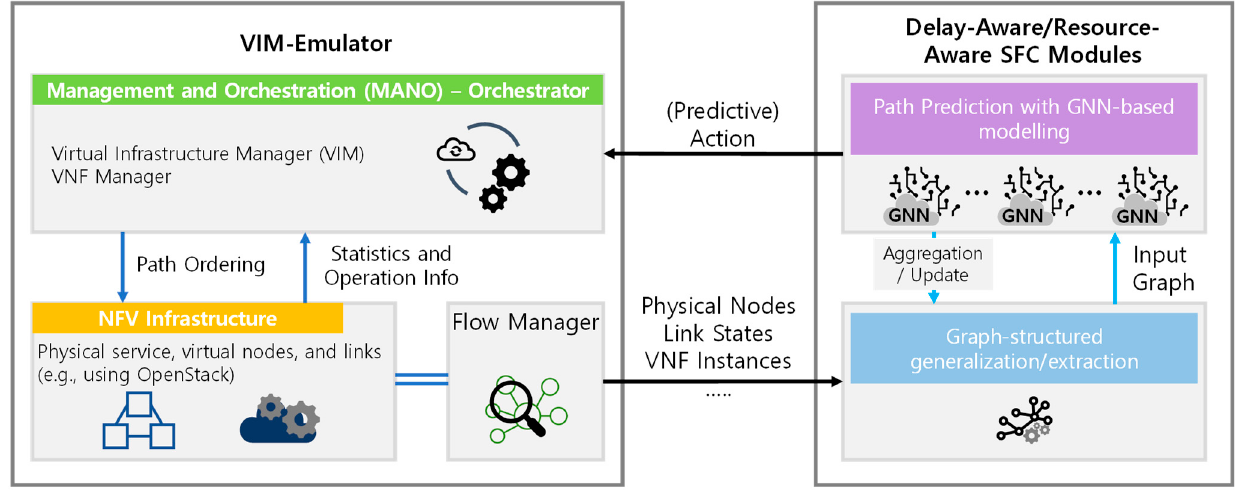
Figure 4. Emerging GNNs for SFC path prediction with delay and resource awareness.